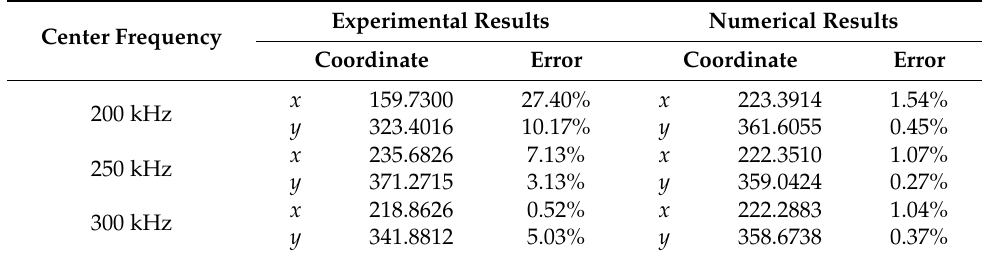
Table 6. Comparison of experimental and simulation results under different center frequencies.